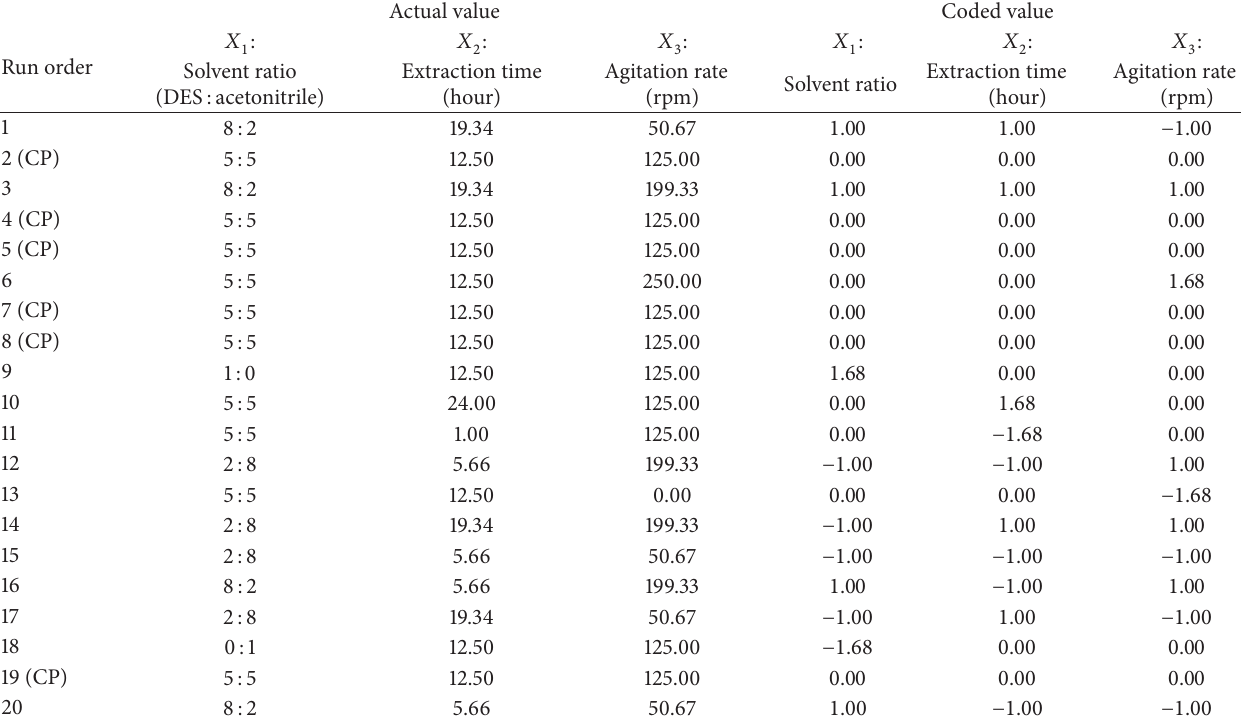
Table 1: Response surface optimization run order actual and coded